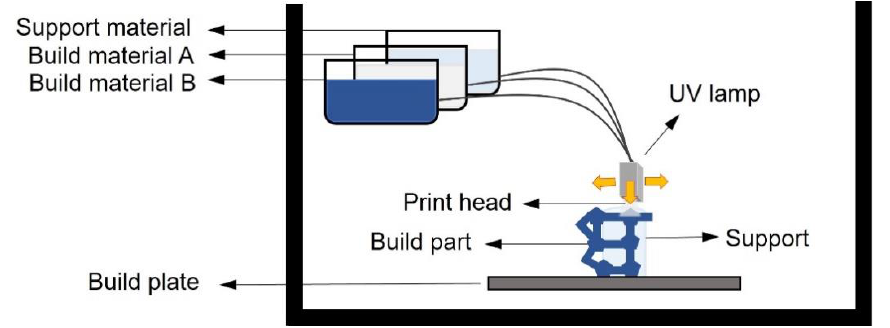
Figure 7. Schematization of MJM printing arrangement.